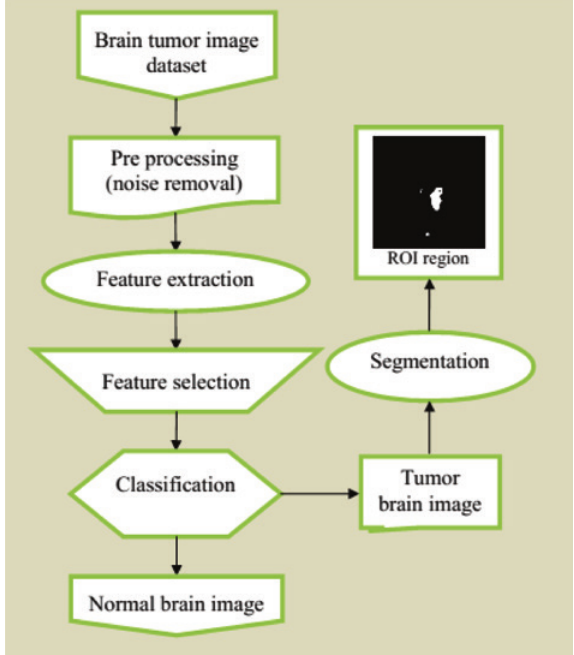
Figure 1: Overall Diagram of the Proposed MRI Brain Tumor Detection